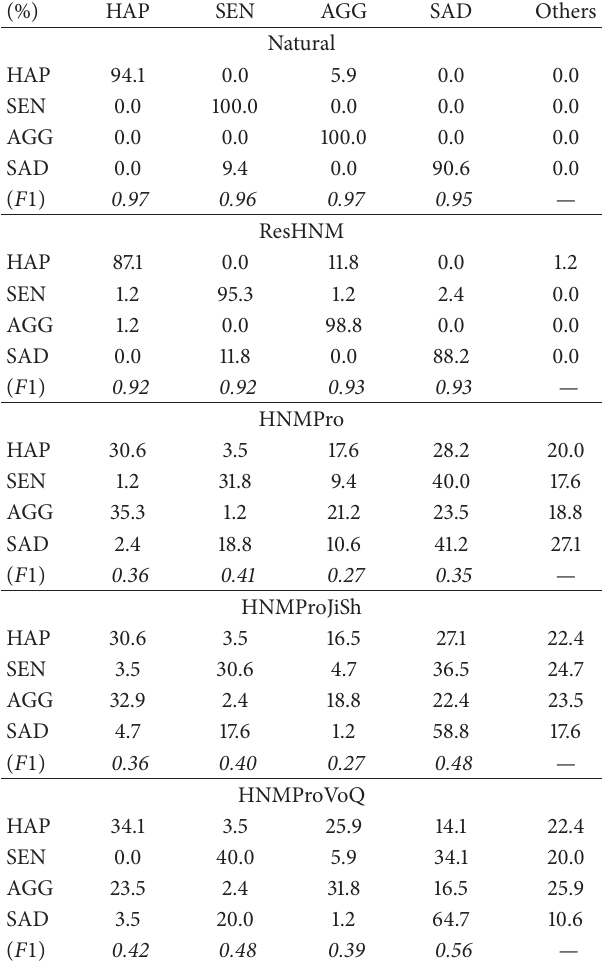
Table 5: The confusion matrix (%) and 𝐹1 measures in the expres- sive speech styles identification for the reference configurations (“Natural” and “ResHNM”) and HNM transformation configura- tions (“HNMPro,” “HNMProJiSh,” and